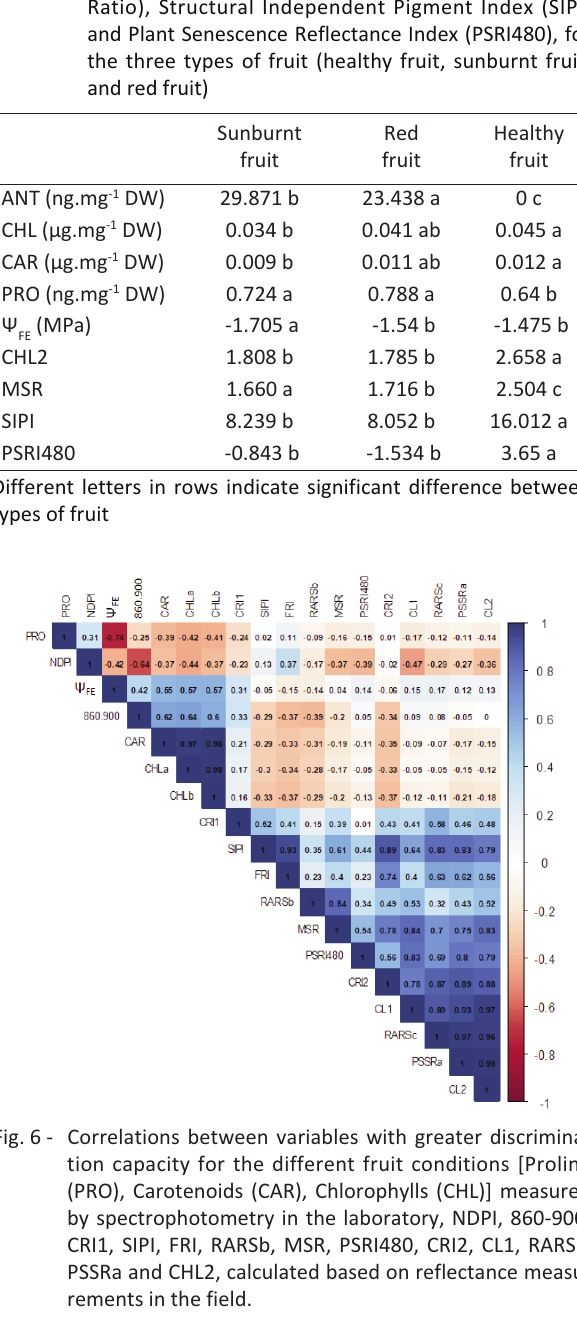
Fig. 5 ­ Boxplot of variables with greater discrimination capacity for the three types of fruit (HF= healthy fruit; SBF= sun­ burnt fruit; RF= red fruit). a) anthocyanin concentration; b) hydric potential of the exposed side of the fruit; c) MSR (modified spectral ratio, chlorophyll concentration estimate by reflectance); d) proline concentration; e) PSRI480 (Plant Senescence Reflectance Index); f. SIPI (Structural Independent Pigment Index).